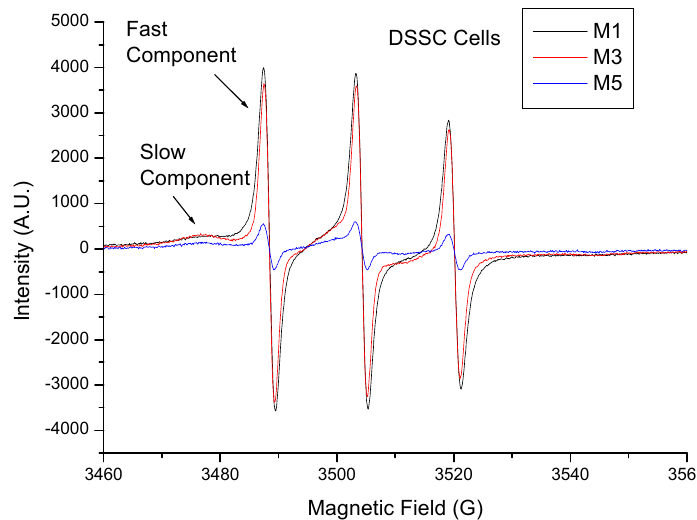
Figure 9. Electron paramagnetic resonance spectroscopy (EPR) spectra of DSSCs sensitized with the chlorine dyes M1 (black line), M3 (red line) and M5 (blue line). The relative fast component and free component of the spectra are shown in the graph.